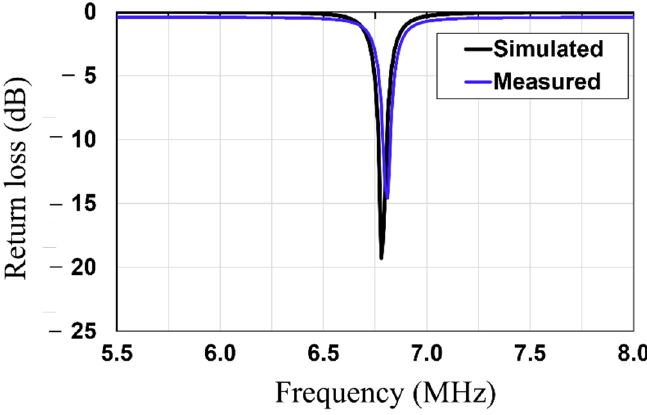
Figure 4. Simulated and measured return losses of the Tx/Rx coils.